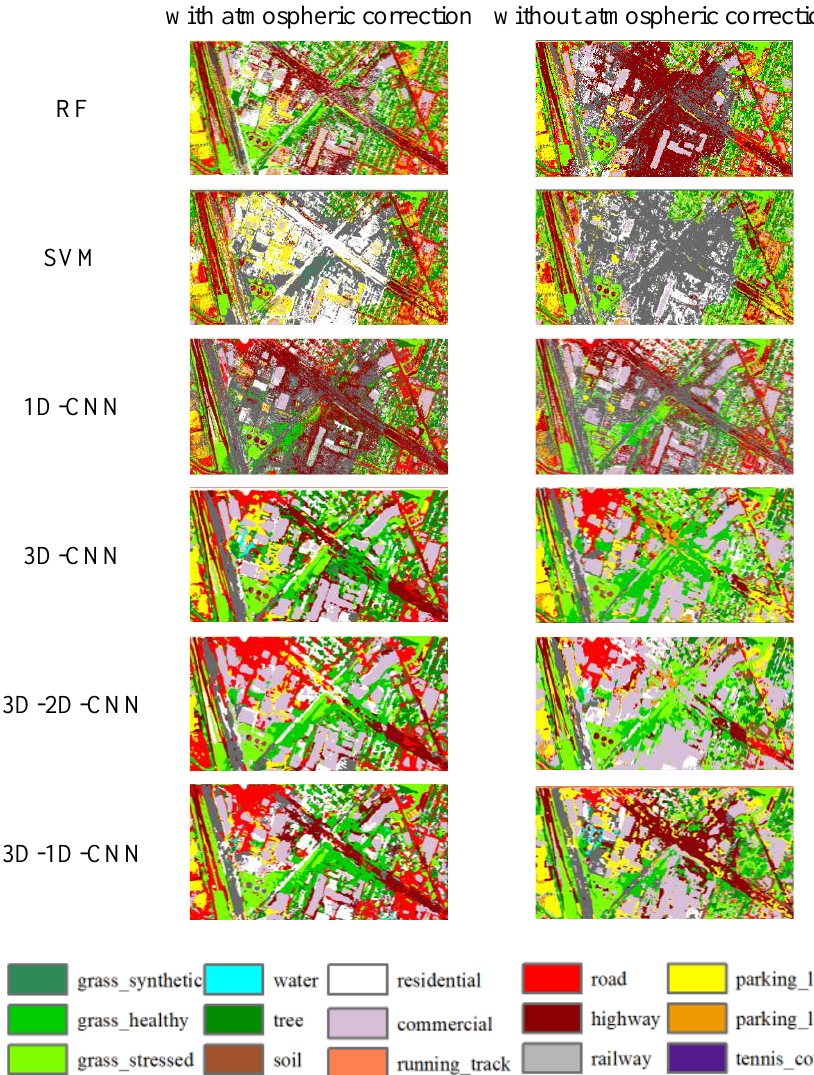
Figure 15. Classification results in the cloud shadow area of the Houston dataset.